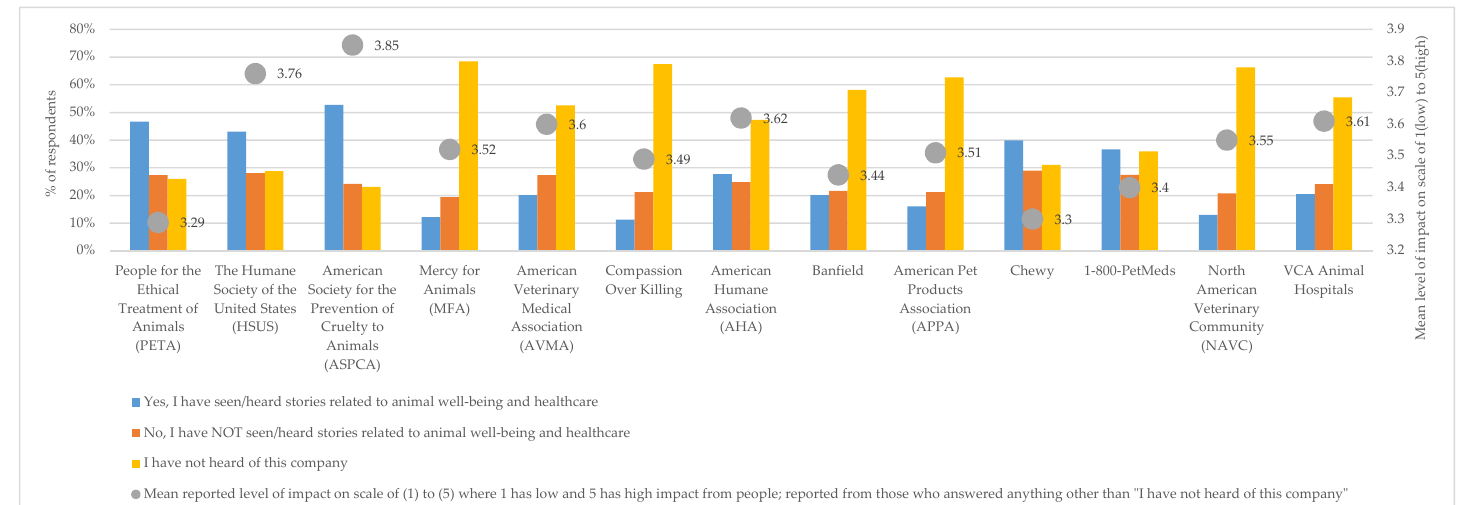
Figure 1. Respondents reported knowledge of animal well-being and health care organization and their mean reported level of impact (For % of respondents n = 1000); for mean level of impact, only those who answered anything other than “I have not heard of this company” were shown the rank question and included in the mean calculation).